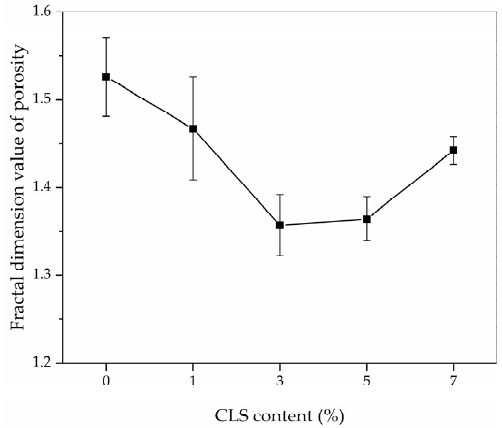
Figure 16. Fractal dimension value of porosity of improved loess with different CLS content.